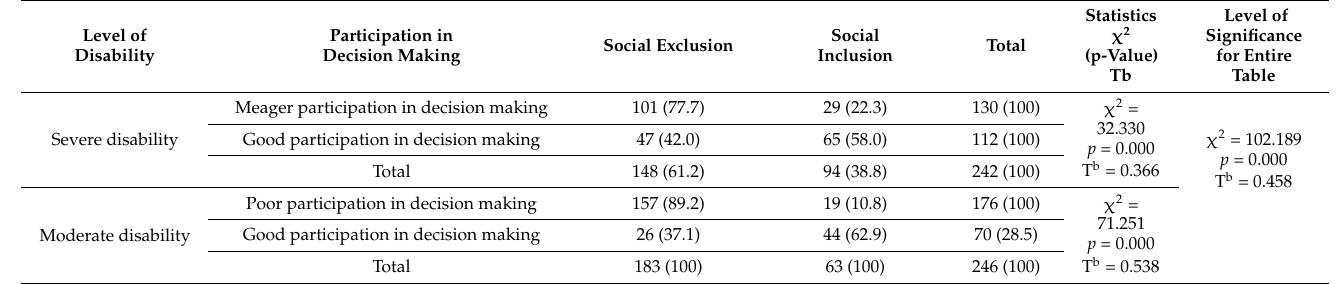
Table 5. Social inclusion of PWDs and participation in decision making while controlling the level of